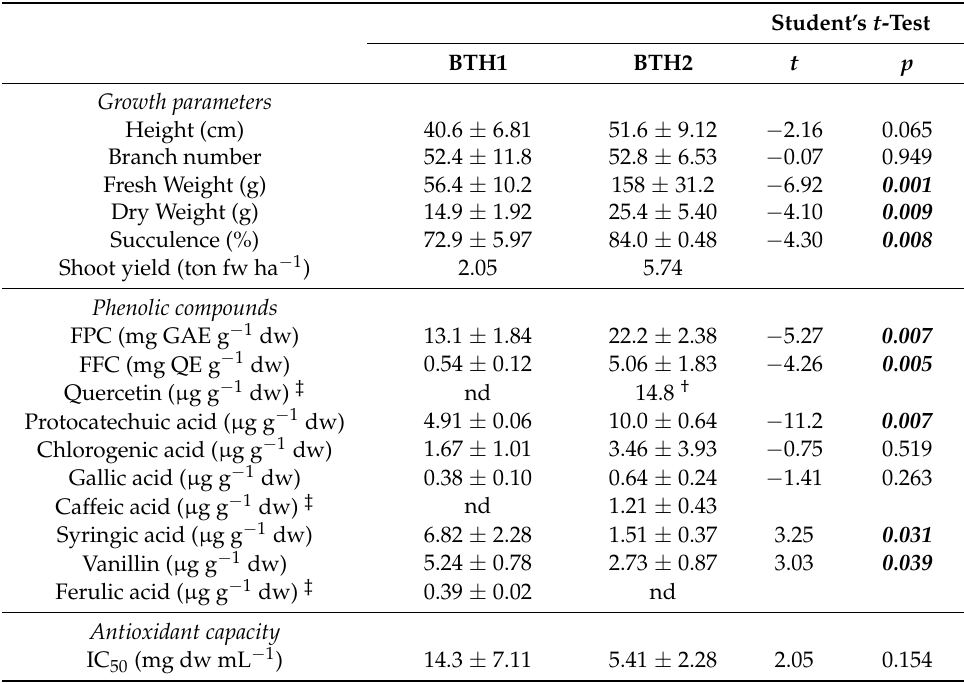
Table 5. Average values ( ± standard deviation) of growth parameters, shoot phenolic compounds and antioxidant capacity of Salicornia neei genotypes (BTH1 and BTH2) after 154 days growth in field plot irrigated with saline shrimp farm